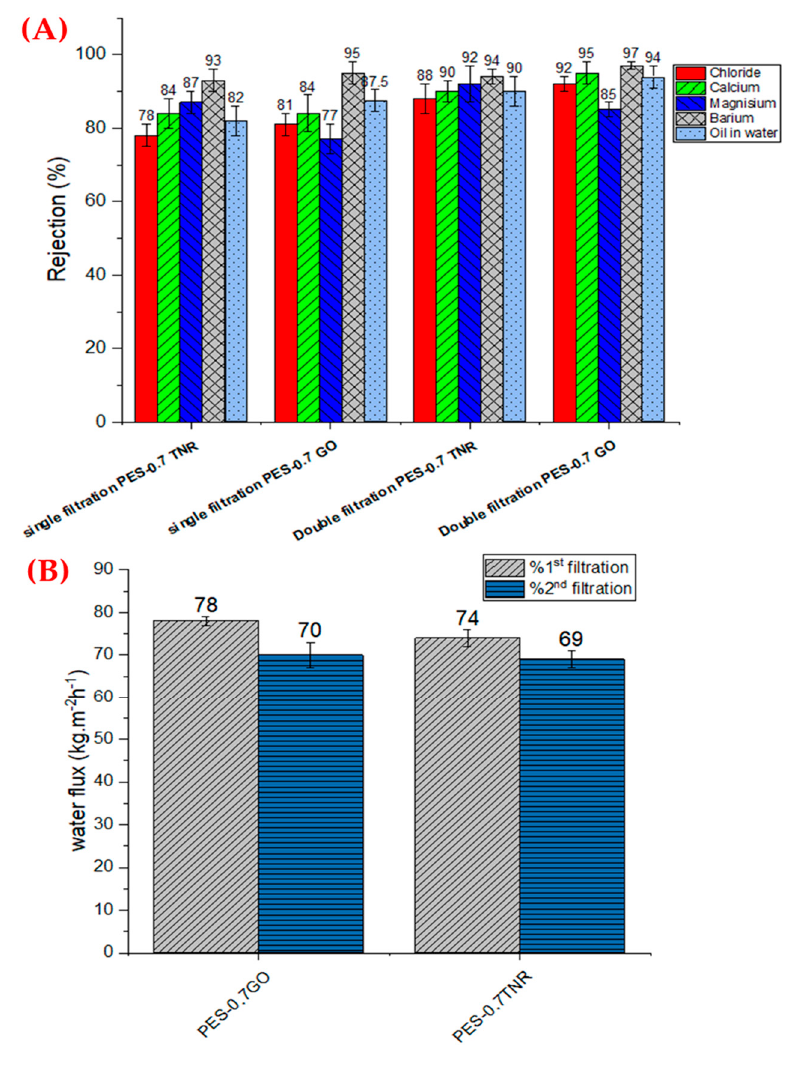
Figure 8. ( A )Salt rejection% and ( B )water flux using PES-0.7 TNR and PES-0.7 GO in a double fil- Figure 8. ( A ) Salt rejection% and ( B ) water flux using PES-0.7 TNR and PES-0.7 GO in a double tration process. filtration